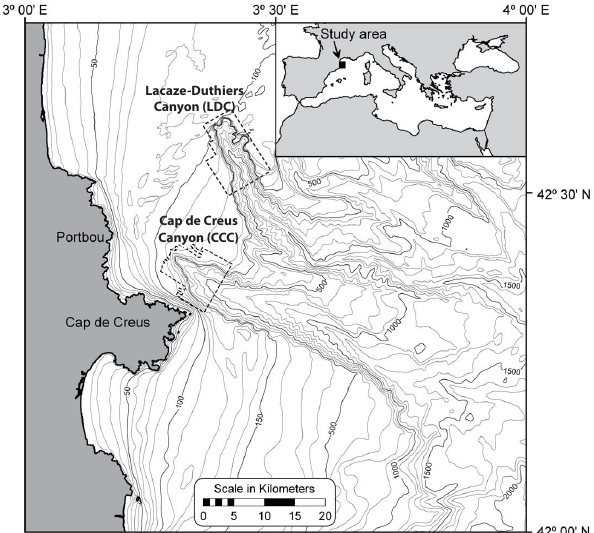
Fig. 1. Bathymetric map and location of the study areas in the west- ern sector of the Gulf of Lions, showing the Cap de Creus Canyon (CCC) and the Lacaze-Duthiers Canyon (LDC). The areas delim- ited with a dashed line correspond to coverage of the multibeam bathymetry illustrated in Fig.